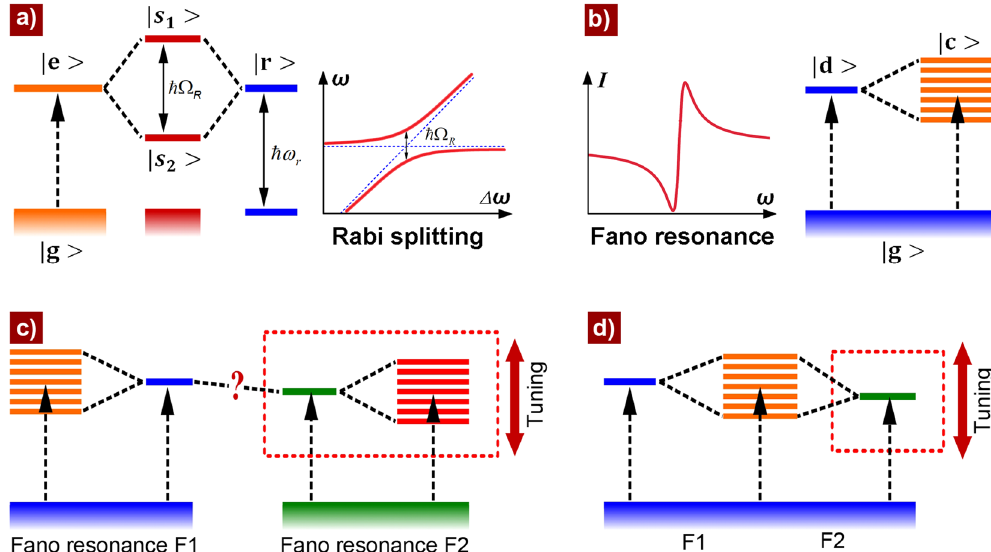
Figure 1. Rabi splitting and Fano resonance. ( a ) Schematic illustration of the Rabi splitting. State > e (excitation states of atoms, molecules, quantum dots, plamons, etc.) strongly couples with resonance state > r (i.e., cavity resonance, plasmonic resonance, etc.) of frequency ω , which causes the levels repelled by a Rabi r  . ( b ) Schematic illustration of the Fano resonance. The interference between a discrete state > d splitting of Ω R and a continuum > c results in the Fano resonance with asymmetric line shape. Both the discrete states and the continuum could be multiple according to Fano’s initial framework 20 . ( c ) Schematic illustration of the possibly existing strong coupling between two Fano resonances if both the discrete state and the continuum of one Fano resonance (for example, F2 as enclosed by the dashed rectangle) could be tuned simultaneously across the other. ( d ) Schematic illustration of the simplified scheme for possible strong coupling between two Fano resonances that share the same continuum state. In such a case, strong interaction between the two Fano resonances may occur by simply varying the discrete state of one Fano resonance (as enclosed by the dashed rectangle). The possibility and results of the strong interaction occurring in Fig. 1c,d have yet been